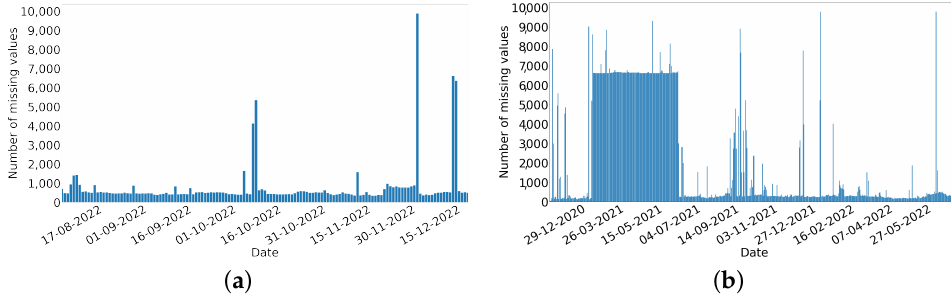
Figure 2. Number of observations that are missing per day for: ( a ) 2 August 2022 to 17